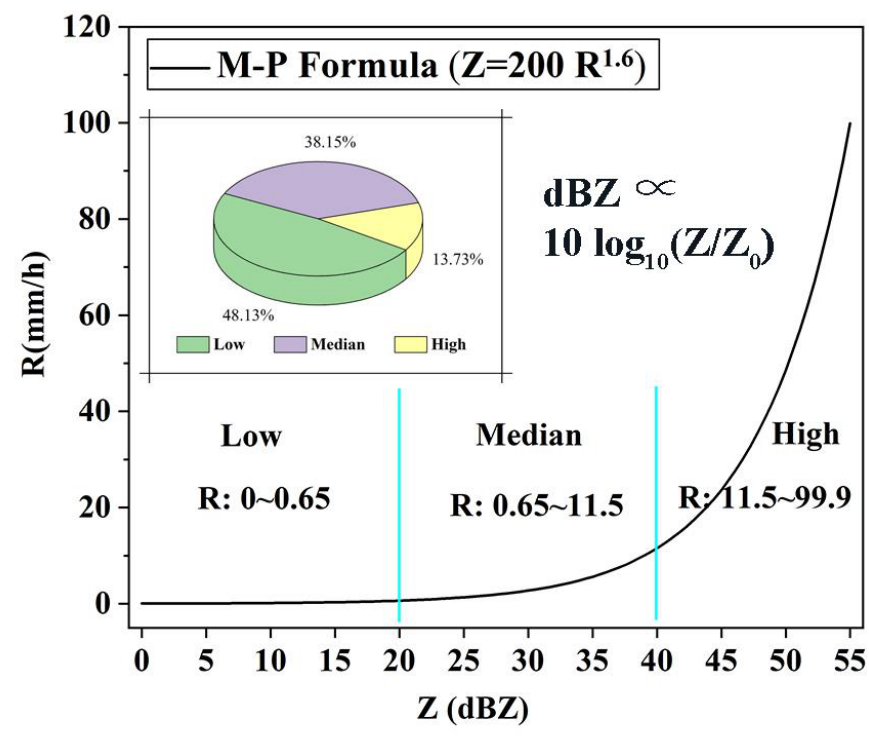
Figure 2. Distribution characteristics of X-band radar data and Z–R relation